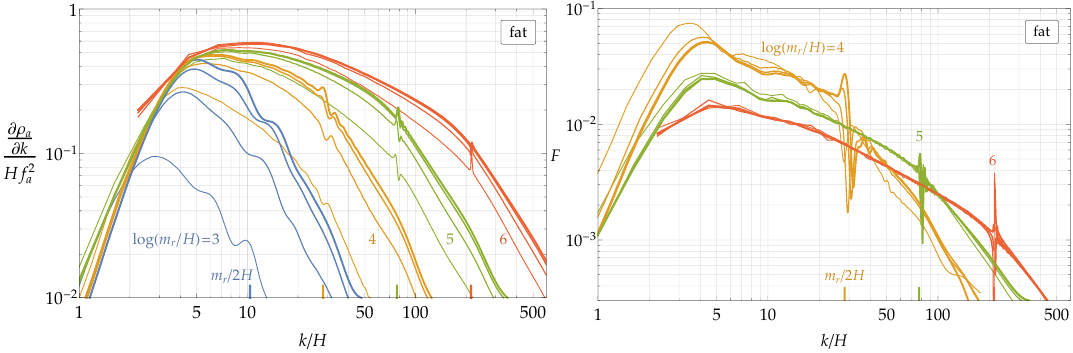
Figure 24 . The convergence of the total axion spectrum (left) and the instantaneous emission spectrum (right), starting from the same set of initial conditions as (cid:12)gure 23, in the fat string system. Simulations with more strings initially are represented by thicker lines, and spectra at the same time instant are represented by the same